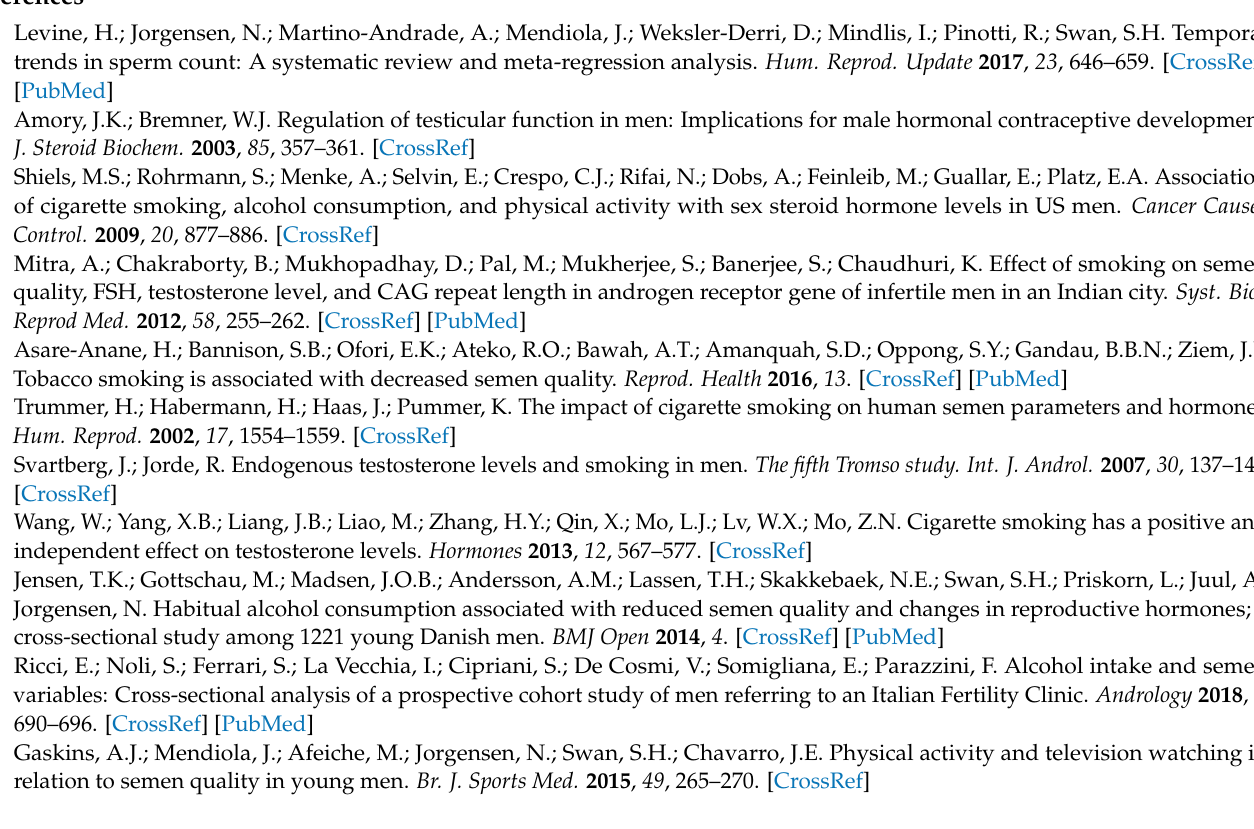
component analysis, Table S2: Adjusted model of beta ( β ) coefficients and 95% confidence intervals (CIs) of sex hormone biomarkers according to the interaction of lifestyle behaviors, Table S3: Adjusted model of beta ( β ) coefficient and 95% confidence intervals (CIs) of sperm biomarkers according to interaction of lifestyle